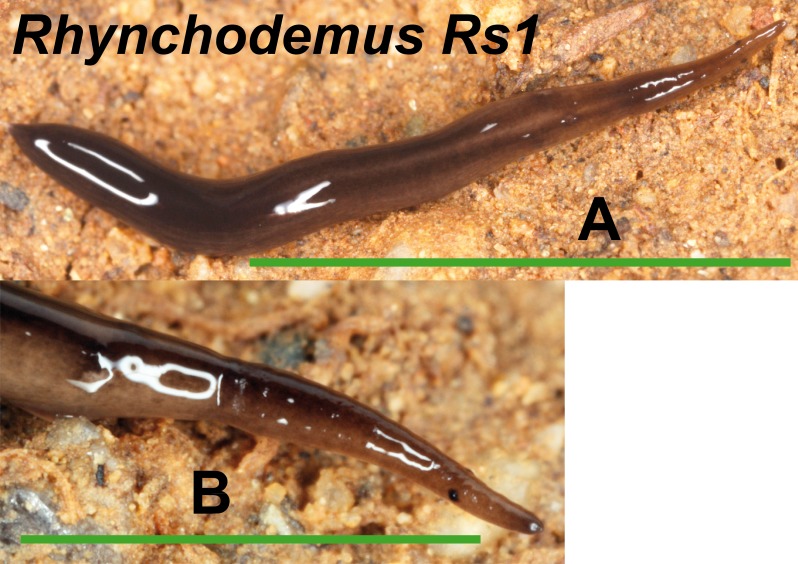
Rhynchodemus morph Rs1.(A) Dorsal view, scale bar 5 mm. (B) Lateral view of anterior region, scale bar 2.5 mm.